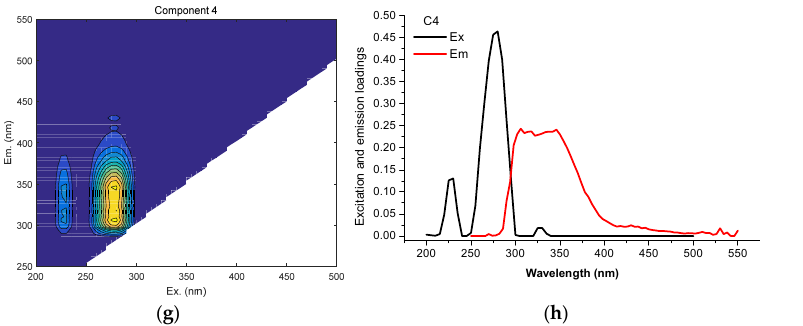
Figure 3. Excitation–emission matrix spectra and spectral loadings of the four components of water-extractable organic matter identified by parallel factor analysis: ( a ) excitation–emission matrix spectra of Component 1; ( b ) spectral loadings of Component 1; ( c ) excitation–emission matrix spectra of Component 2; ( d ) spectral loadings of Component 2; ( e ) excitation–emission matrix spectra of Component 3; ( f ) spectral loadings of Component 3; ( g ) excitation–emission matrix spectra of Component 4; ( h ) spectral loadings of Component 4. Table 3. Spectral characteristics of the four components of water-extractable organic matter in the topsoil identified by parallel factor